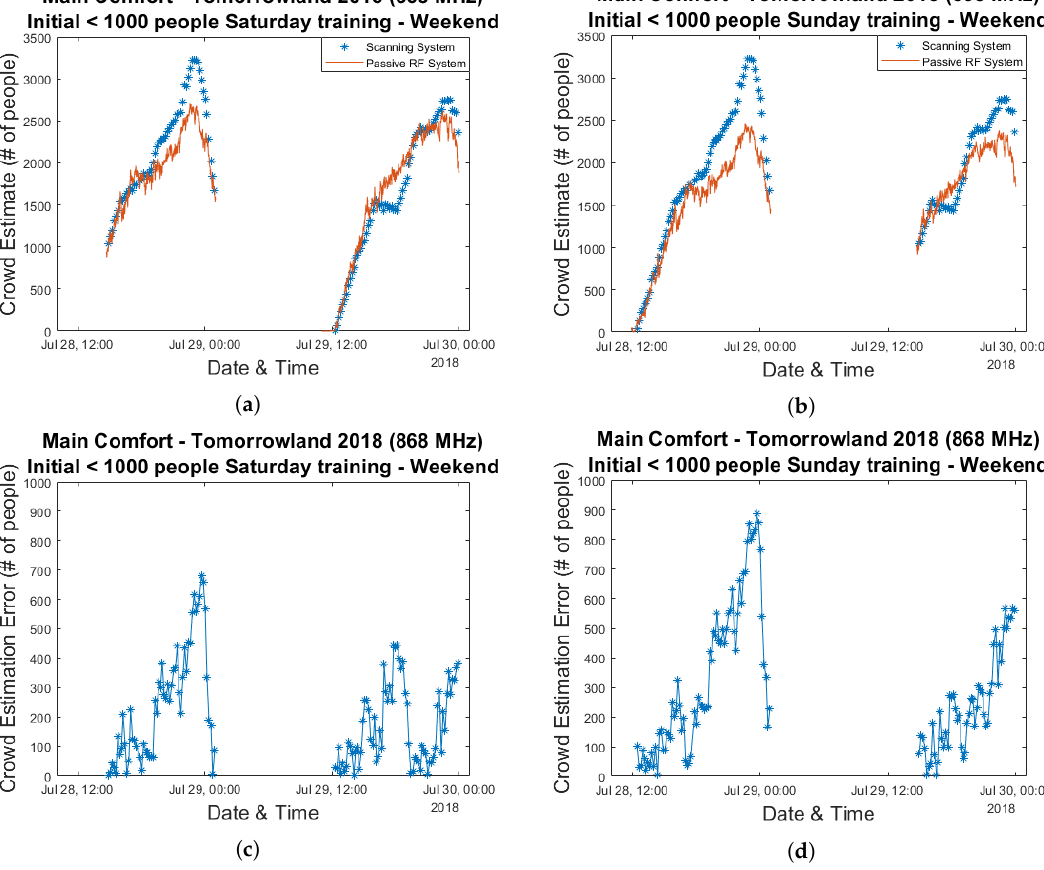
Figure 9. Crowd estimation graphs and their corresponding error graphs for a model trained using the data from a single day up until a crowd size of 1000 people was measured by the scanning system and evaluated based on all remaining data collected during both days. Plots ( a , c ) were created based on training data collected on Saturday 28 July 2018 and evaluated based on the remaining data from both days. Plots ( b , d ) were created based on training data collected on Sunday 29 July 2018 and evaluated based on the remaining data from both